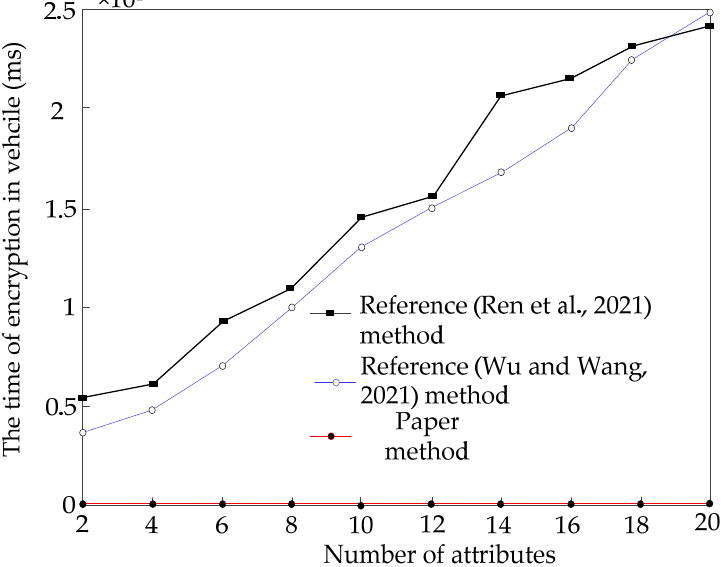
Figure 7. Time cost of private vehicle encryption under different methods [6, 7].